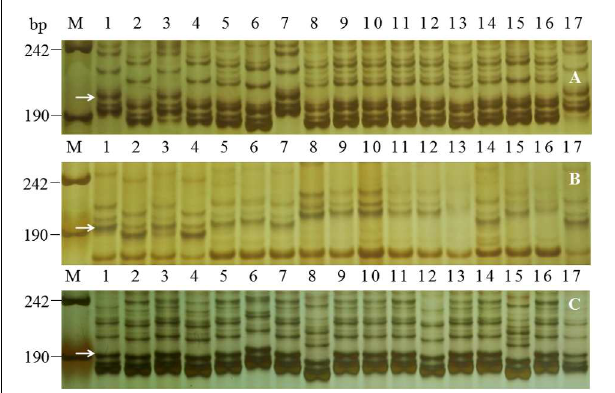
FIGURE 4 | Polymerase chain reaction (PCR) amplification patterns of FG-1 and wheat genotypes with documented Pm genes at or near the